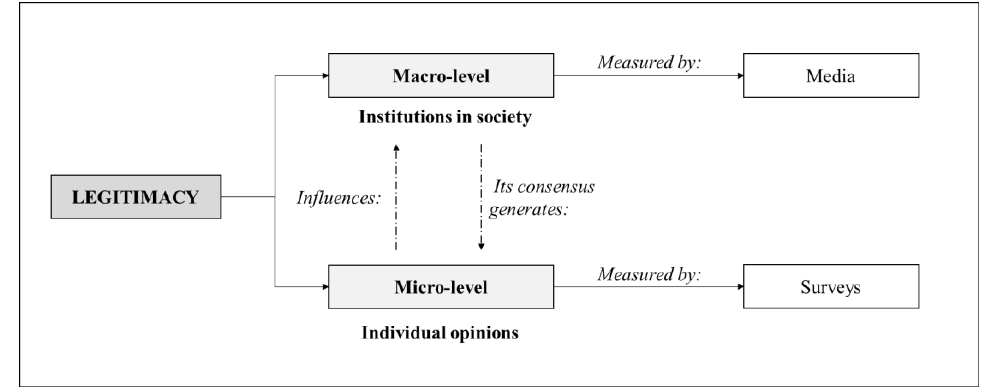
Figure 1. Macro level and Micro level. Source: Own elaboration.